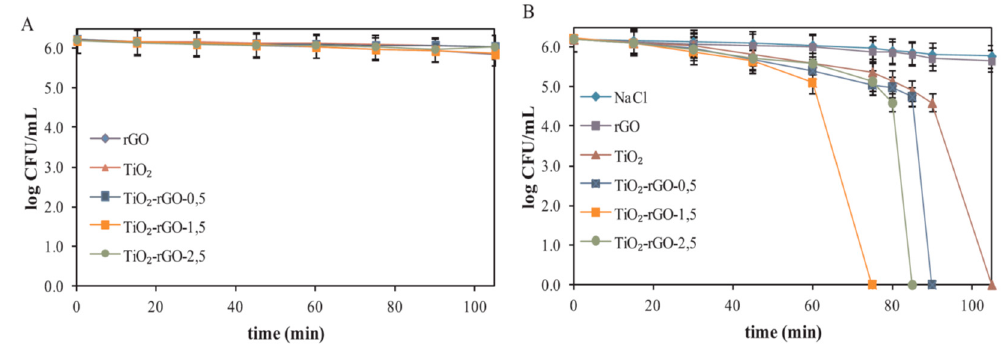
Figure 27. Inactivation of E. coli in the presence of rGO, TiO 2 and (0.5–2.5 wt%) rGO / TiO 2 samples in ( A ) dark contition and ( B ) under artificial solar light irradiation. Reproduced with permission from [101]. Copyright Elsevier, 2018.